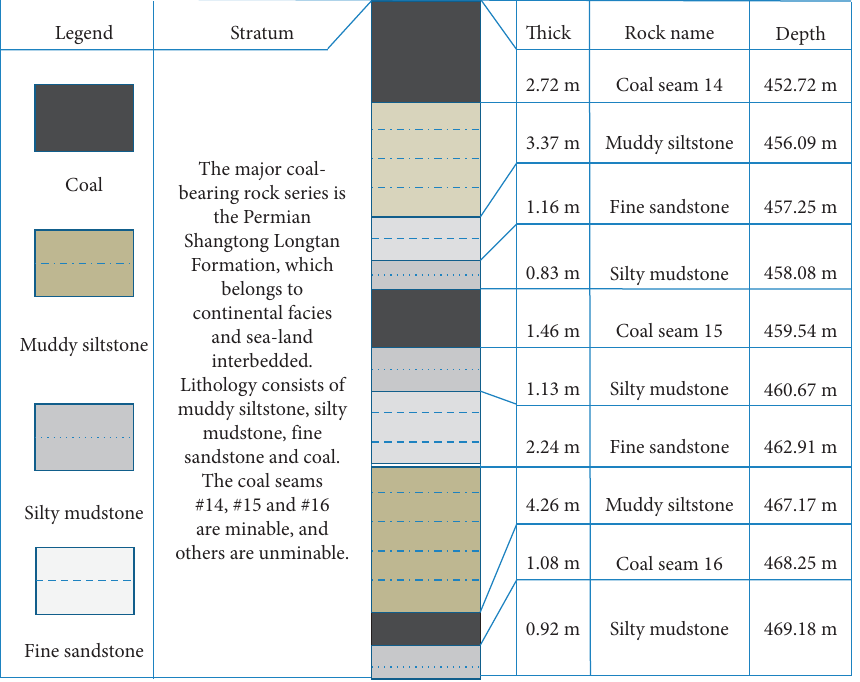
Figure 3: Coal seam histogram.